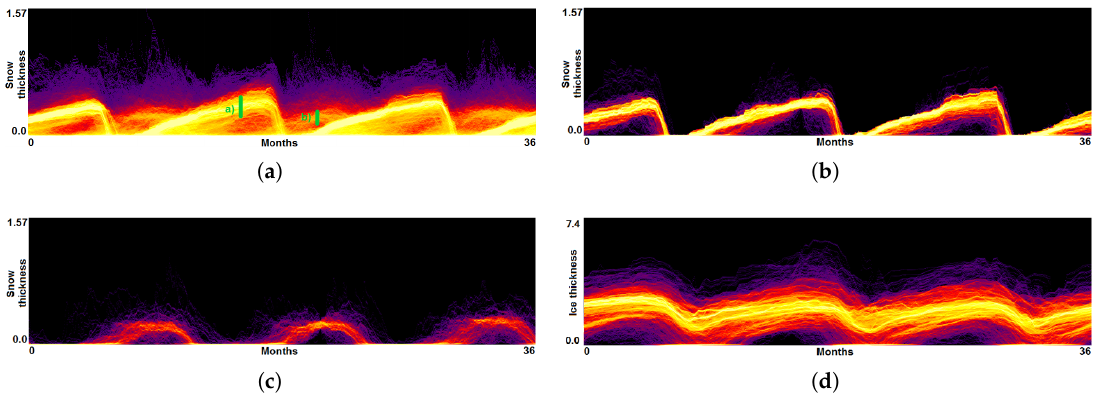
Figure 16. ( a ) Function plot for snow thickness aggregated over all climate simulation runs exhibits annual patterns of 3 years, which are selected as shown in green. ( b , c ) Function plots for snow thickness when filtering the trajectories according to selections a and b . ( d ) Function plots for ice thickness (as in Figure 1) when filtering the trajectories according to selection a .